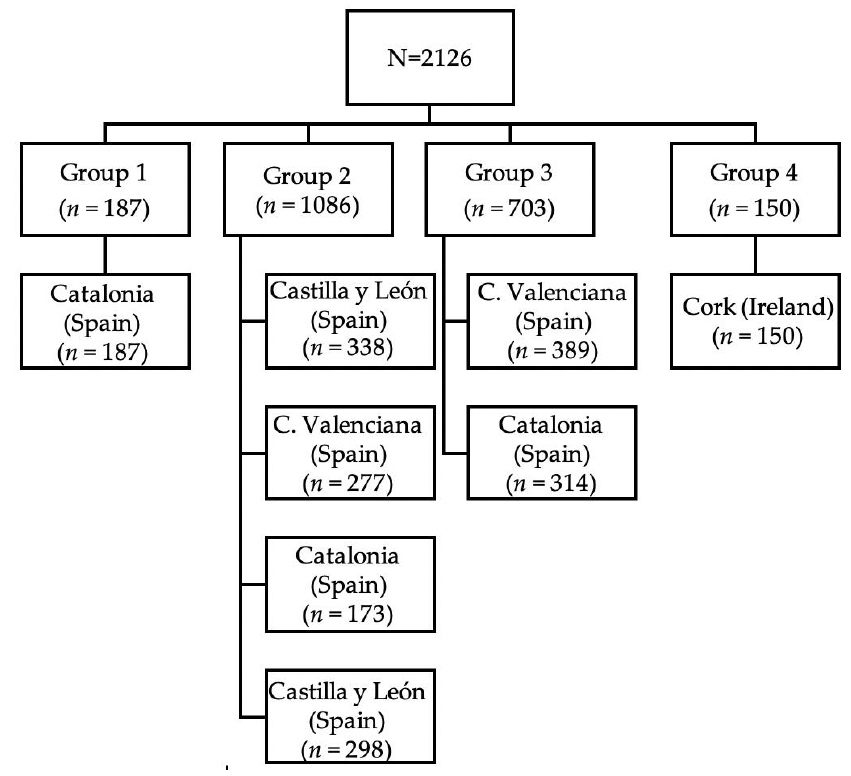
Figure 1. Study flow chart.